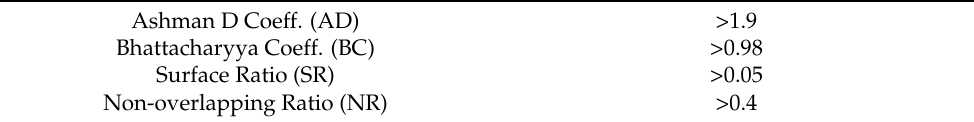
Table A1. Tile selection thresholds for landslide